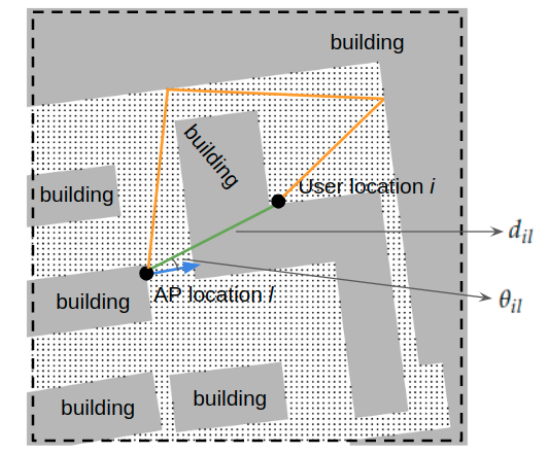
Figure 5. The limitations of the Euclidean distance-based model. The blue arrow represents the broad- side direction for the array at the AP location. The green straight line indicates the Euclidean distance between user location i and AP location l . The orange polyline indicates a possible propagation path from AP location l to user location i